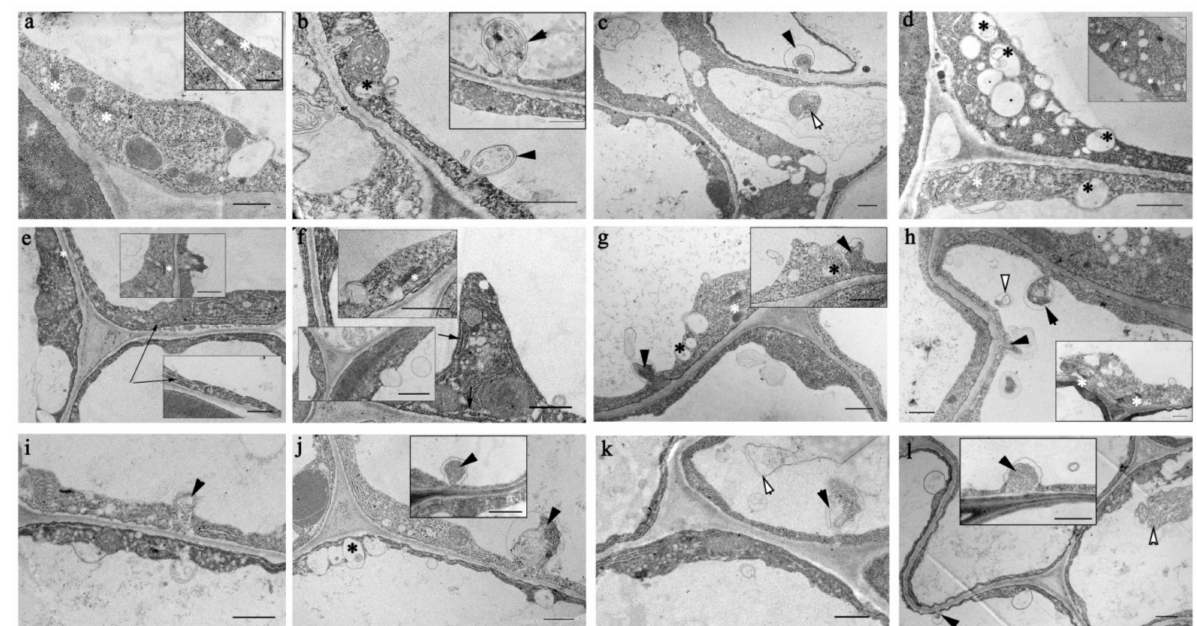
Figure 6. Transmission electron micrographs of root cells of 4-day-old seedlings of A. thaliana WT ( a – d ) and Atflot1ko knockout mutant ( e – l ) grown either in the absence ( a , b , e – h ) or in the presence ( c , d , i – l ) of NaCl. Black asterisks indicate multivesicular bodies (MVBs), white asterisks indicate Golgi complexes (GCs), black short arrows indicate paramural bodies (PMBs), white short arrows indicate derivatives of paramural bodies (PMBDs), and black long arrow indicate the ER. Scale—1 µ m.